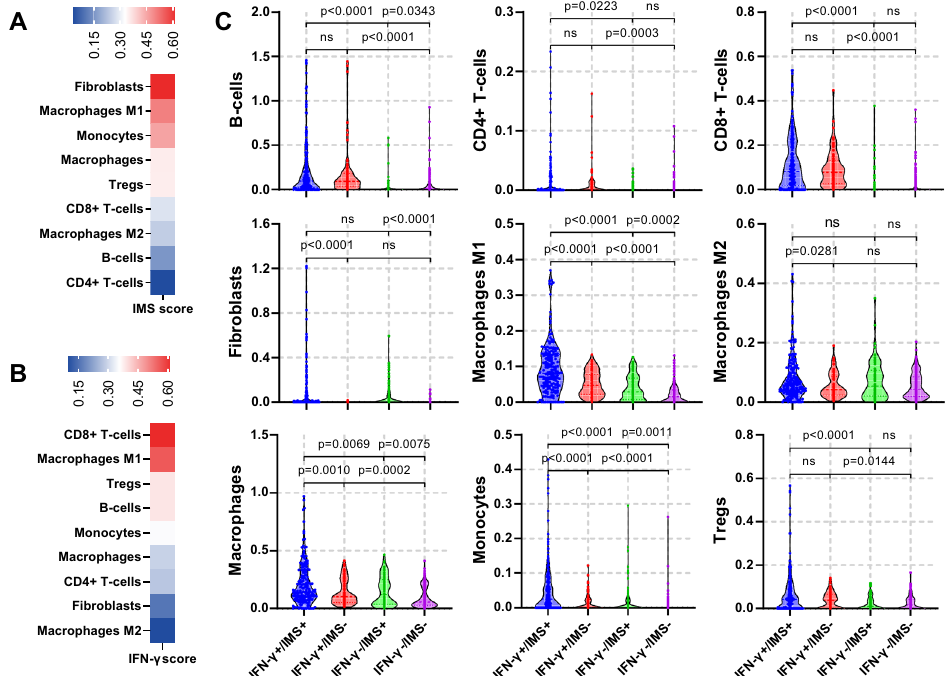
Fig. 2 Association of IMS with abundance of immune cell types in TME. A , B Heatmap showing the Pearson correlation of selected immune cell types with IMS scores (in A ) and IFN- γ (in B ) in combined melanoma cohorts consisting of all samples from the discovery cohort and TCGA melanoma dataset ( n = 516). Fibroblasts showed the strongest association with the IMS score (Pearson correlation r = 0.62, p < 0.001), followed by M1 macrophage ( r = 0.50, p < 0.001), monocytes ( r = 0.45, p < 0.001) and macrophage ( r = 0.35, p < 0.001). On the other hand, CD8 + T cell showed the strongest association with the IFN- γ score ( r = 0.61, p < 0.0001). C , Violin plot showing the cell type distributions estimated using xCell for 4 groups of patients with IFN- γ + /IMS + ( n = 183), IFN- γ + /IMS − ( n = 75), IFN- γ -/IMS + ( n = 75), IFG- γ -/IMS − ( n = 183) in the combined melanoma cohort. Cutoff values for the IFN- γ signature and IMS scores were set to their median in all the ( p = 0.0281) but not the IFN- γ − subgroups. On the other hand,